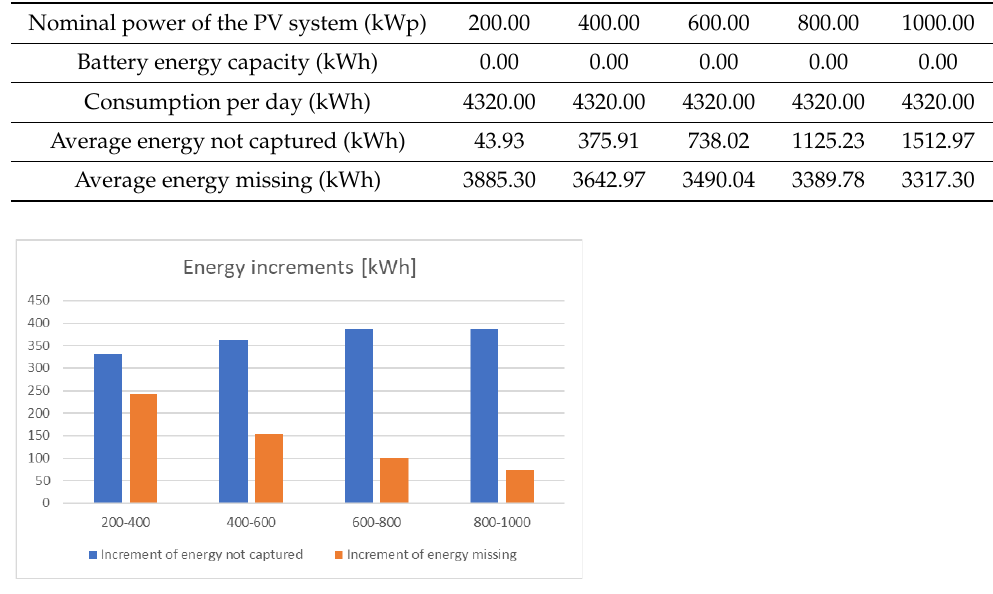
Figure 5. Increases in unused and missing energy for PV installations from 200 to 1000 kWp (daily average).